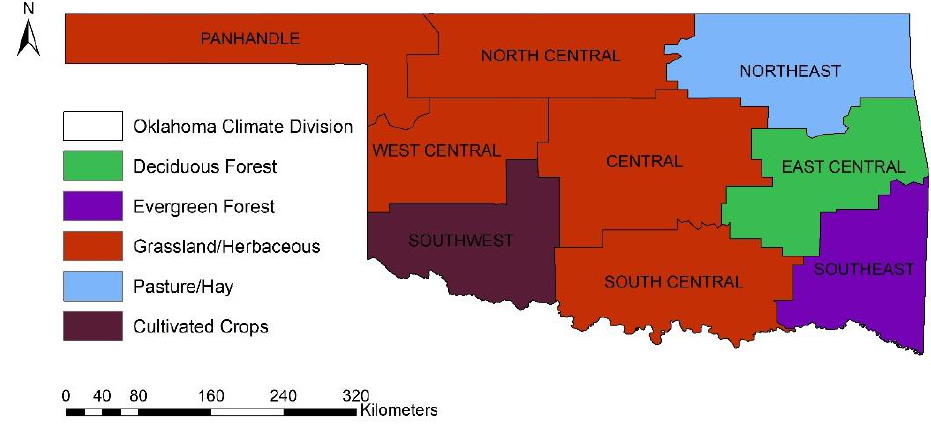
Figure 2. Oklahoma climate divisions with their major land cover types based on the 2016 NLCD map.